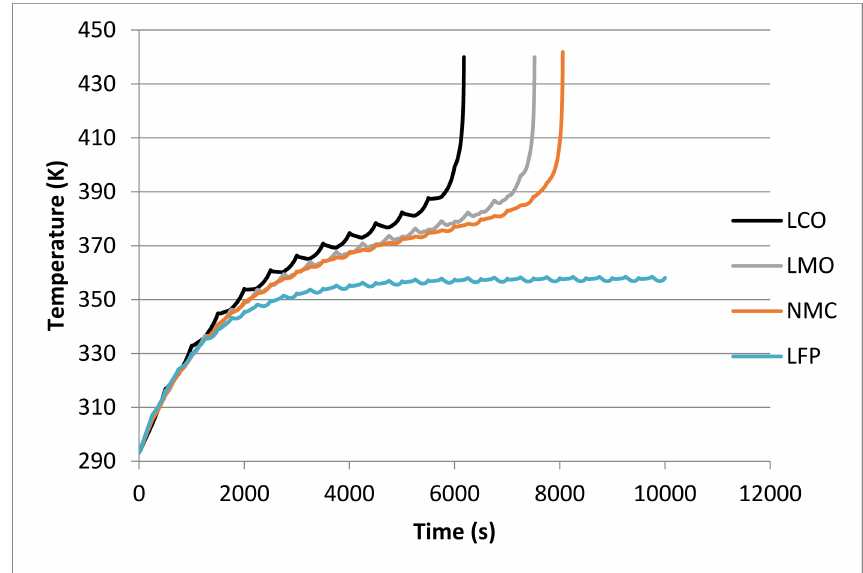
Figure 12. Temperature profiles as a function of time (h = 8 W/m 2 K).